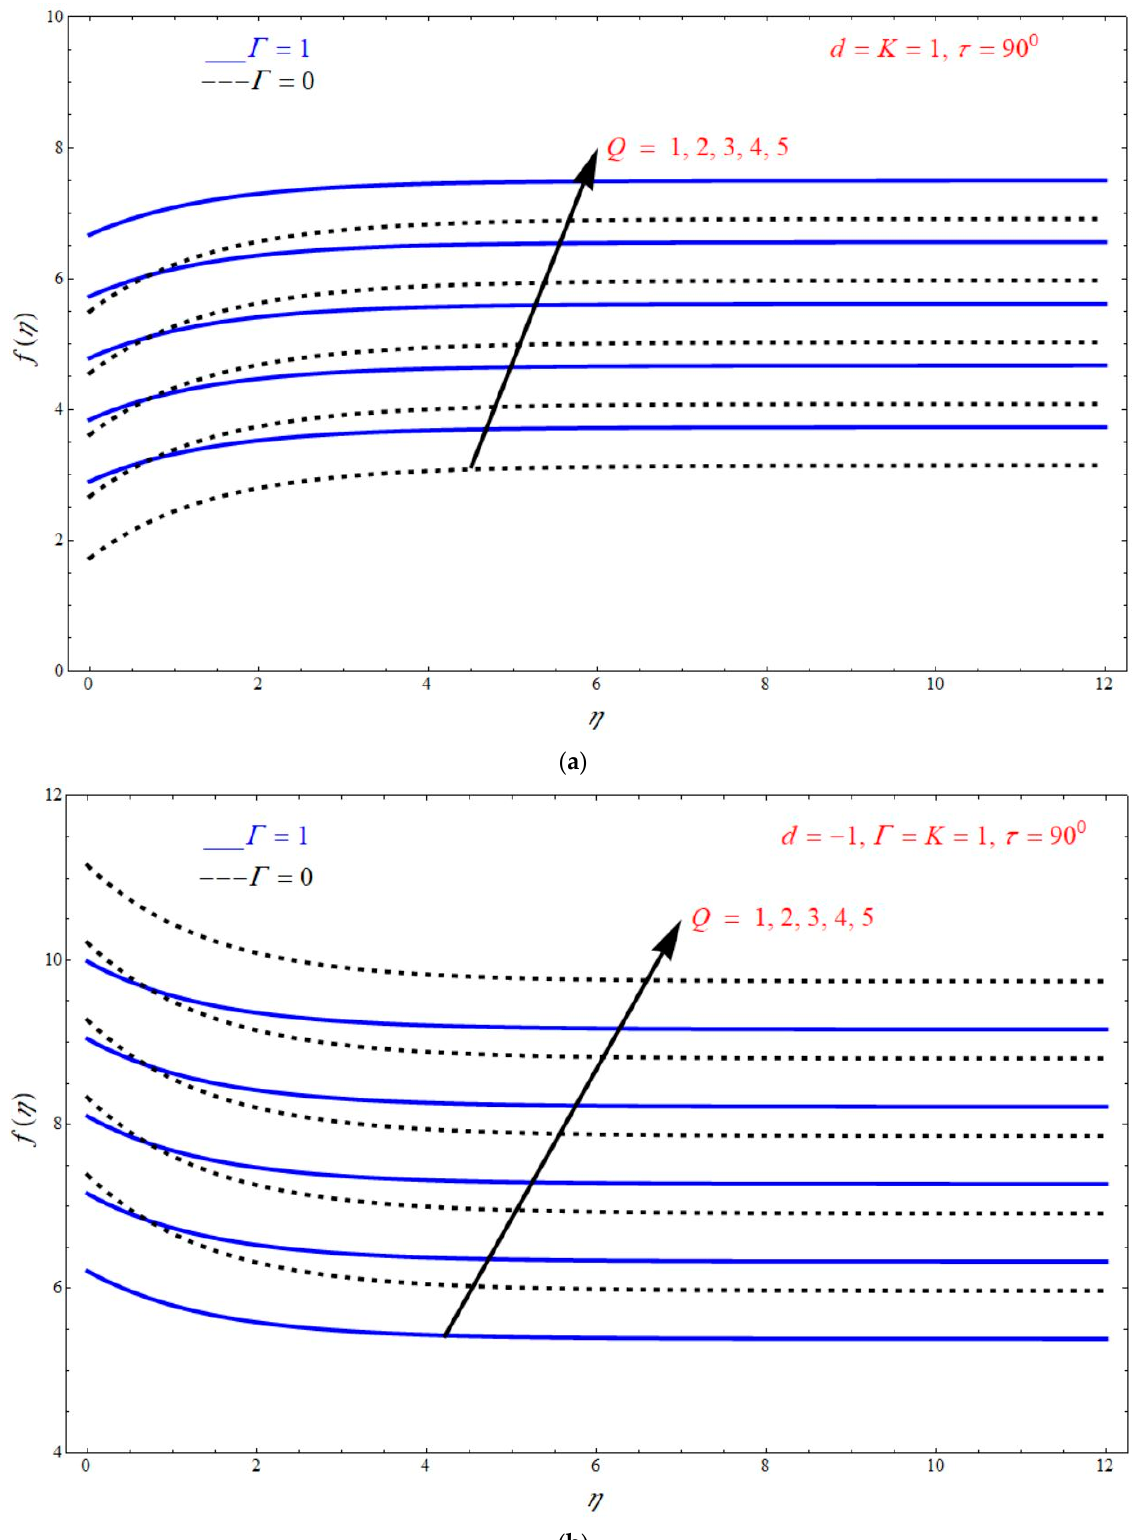
= − . Figure 2. Impact of f ( η ) on η for various choices of Q for ( a ) d = 1 and ( b ) d = −